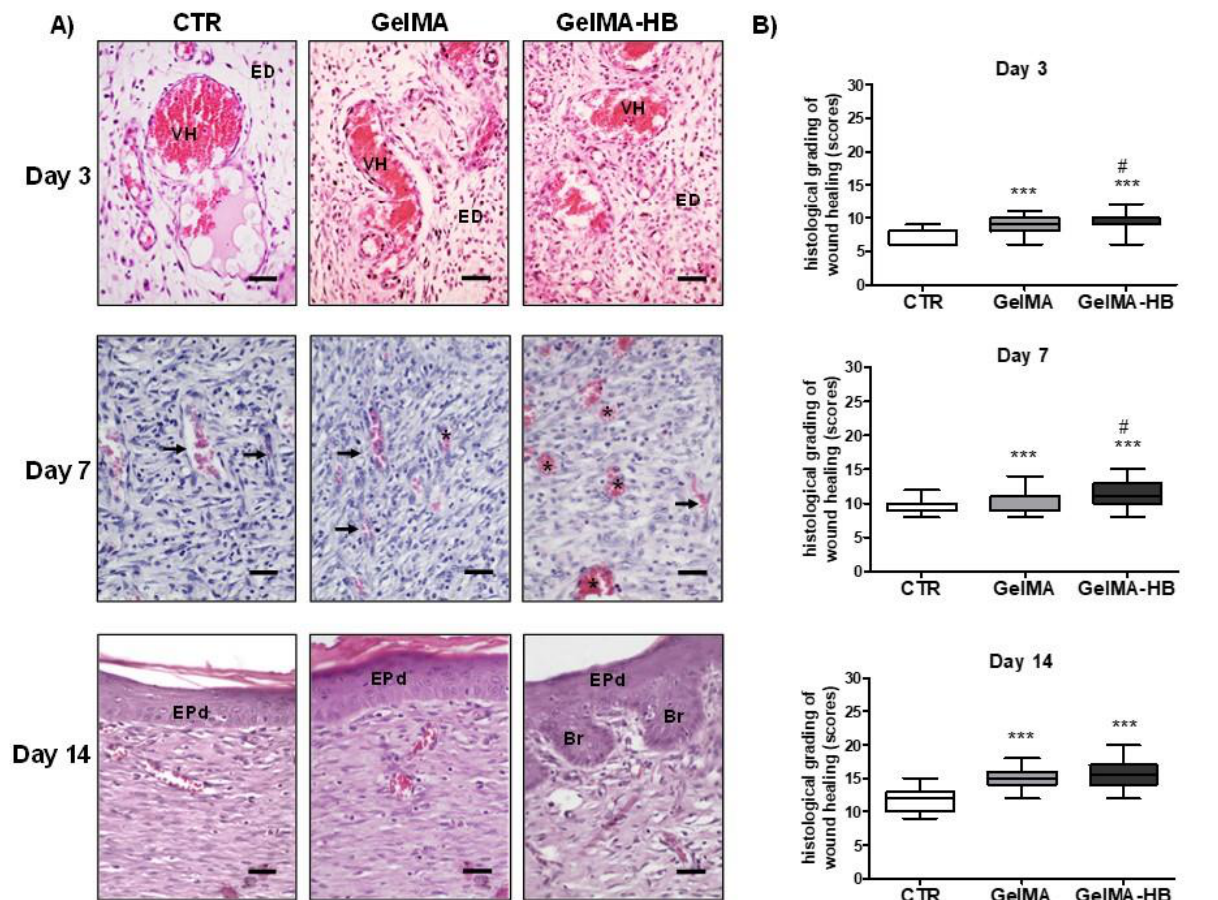
Figure 4. ( A ) Photomicrographs of representative histological sections of the experimental groups. (Day 3) Exudative changes, inflammation, and hyperemic vessels were observed in the three groups. Note less intense connective tissue edema and inflammation on GelMA-HB. (Day 7) Exuberant granulation tissue was observed in the three groups. Note more cellularized tissue and vessels with a more mature morphological appearance in GelMA-HB. (Day 14) Primary fibrous scar and re- epithelialization of the wound surface in the studied groups. The dermo-epidermal interface appears flat in CTR and GelMA, but exhibits epithelial budding (rudimentary cutaneous attachments) in GelMA-HB (HE, 400 x; bar = 20 µ m). ( B ) Assessment of histological gradation scores of scar repair over the experimental period (data presented as median and interquartile range). Differences compared to CTR are expressed as *** p < 0.001 and differences compared with GelMA are expressed as # p < 0.05 (Kruskal–Wallis, followed by Dunn’s multiple comparisons test). Legend: VH—hyperemic vessels; ED—Interstitial edema; arrows—“slit”-shaped capillaries; asterisks—more regular rounded vessels, dilated and congested; EPd—epidermal tissue (stratified squamous epithelium); Br—epithelial buds compatible with rudimentary cutaneous attachments.